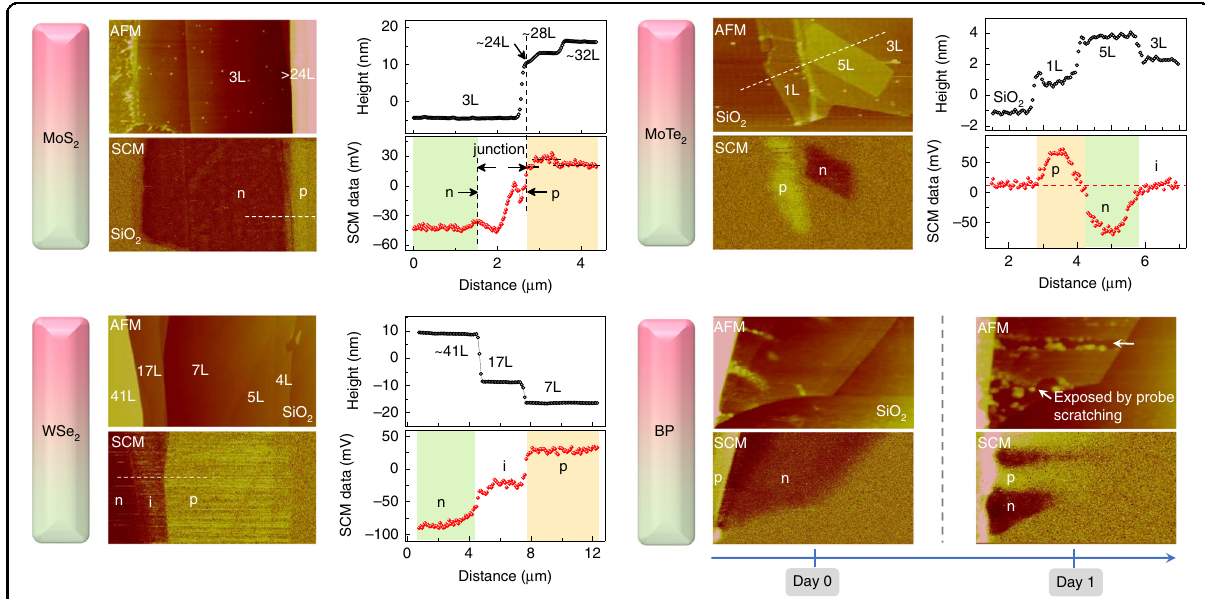
Fig. 2 Charge-carrier distribution in layered materials. AFM and SCM images of layered MoS 2 , MoTe 2 , WSe 2 and BP, showing the morphology, the polarity and distribution of charge carriers beneath. Note that zero response (SCM data) at oxide layer means that it is insulating, a positive/negative signal would imply a dominant response from hole/electron carriers. For BP materials, images show clear difference between the freshly exfoliated (Day 0, leading electron/hole response from few-/multi-layer BP) and oxidized states (Day 1, dominated hole response from all regions). At Day 1, we teared off the upper surface by probe scratching. The electron response was recovered in this